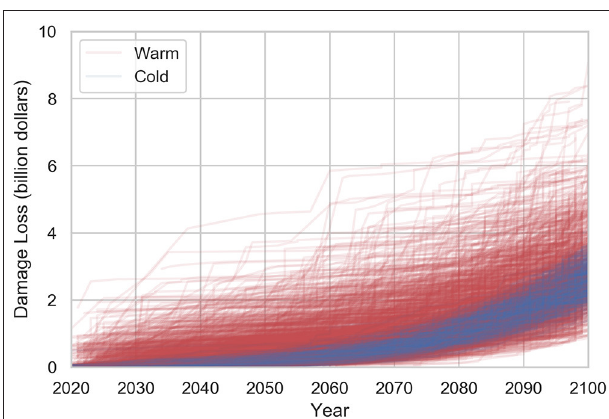
FIGURE 5 | An example of the cumulative direct damage (i.e., the summation of physical damage loss, income loss, inventory loss, and loss from interdependencies) from storm-induced flooding over the next 80 years (2020–2100) resulting from 1,000 different simulations in Lower Manhattan in NYC (without any protective measures present). The total cumulative damage cost/loss over the years varies for each simulation because of the different randomly generated storm events in each one of the 1,000 simulations. Blue lines indicate damage losses from cold-season storms. Red lines indicate damage losses from warm-season